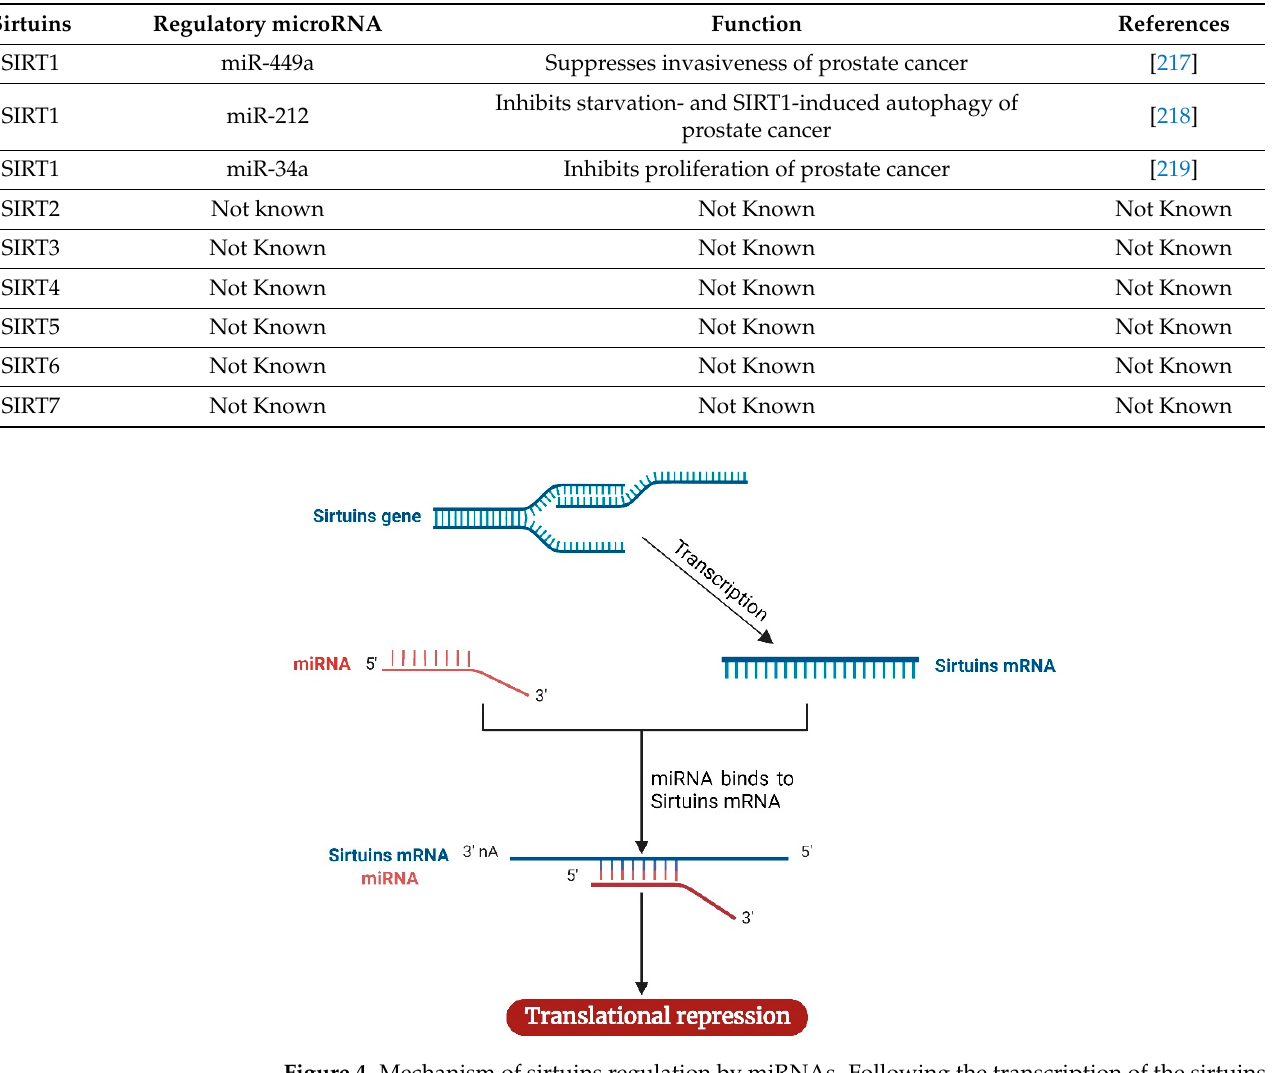
Figure 4. Mechanism of sirtuins regulation by miRNAs. Following the transcription of the sirtuins gene to mRNA, miRNA complementary to sirtuins binds the sirtuins mRNA, causing the repression of sirtuins mRNA translation. The image was created with